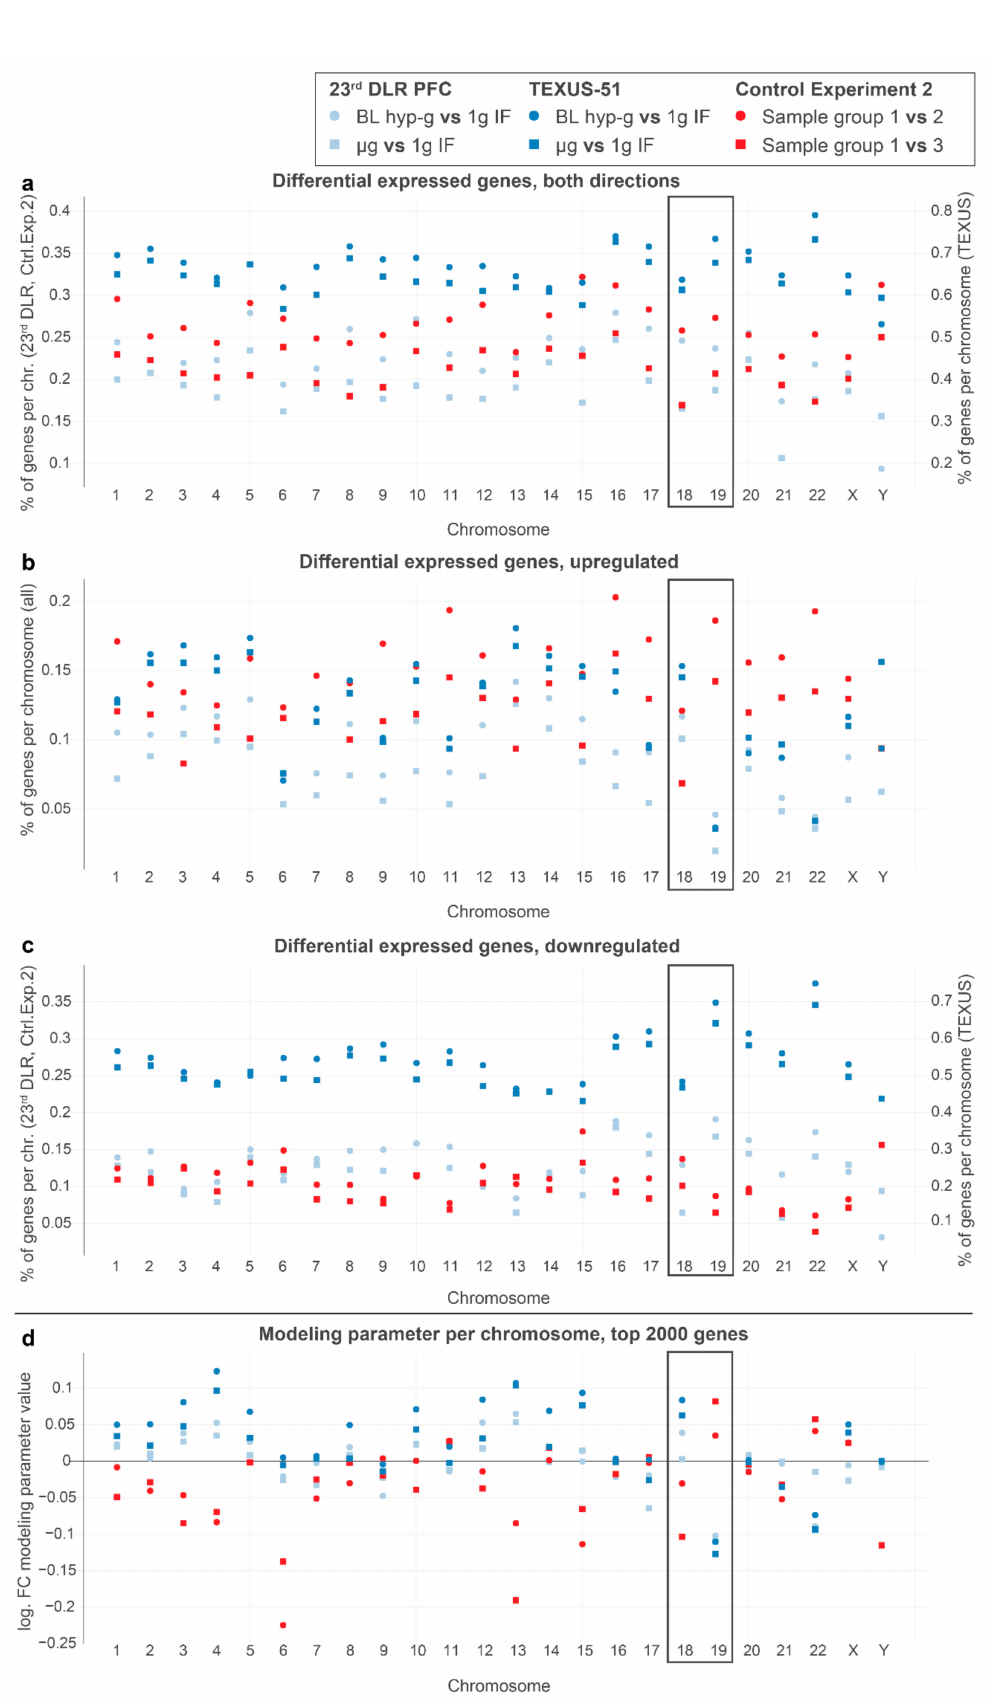
Figure 5. Pinpointing differential gene expression to single chromosomes. ( a – c ) The percentage of differentially expressed genes, defined as genes with uncorrected p of <0.05 divided by the number of all measured genes per chromosome for